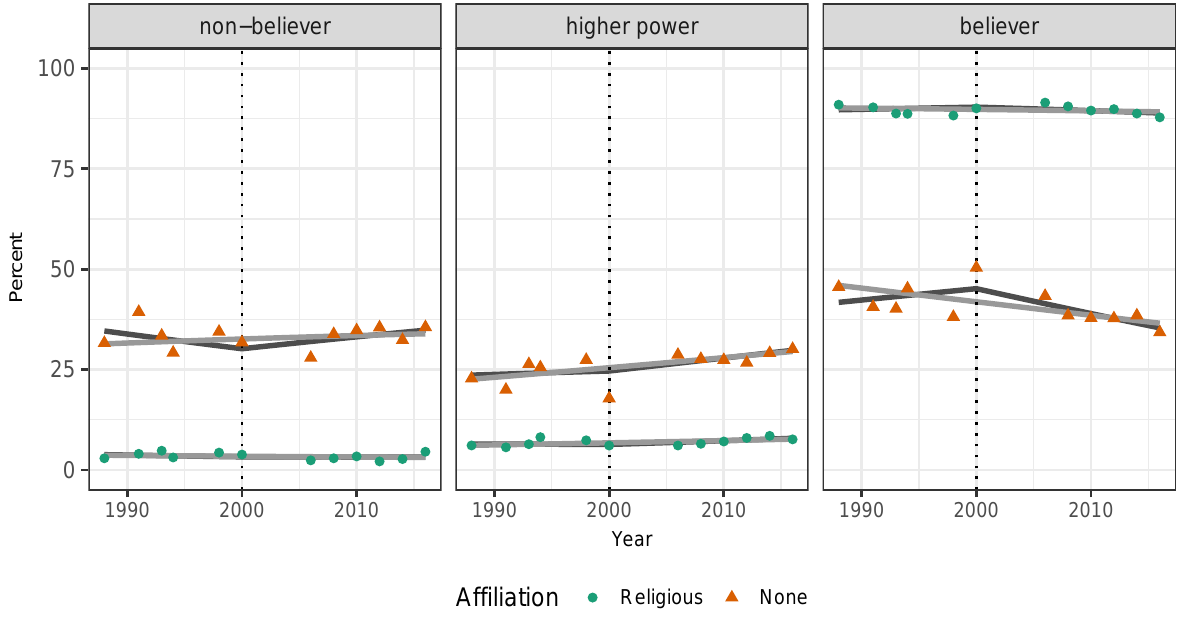
Figure 3: Percentage of General Social Survey respondents in each year who held given beliefs about God by affiliation status. All percentages are sample weighted. The fit of multinomial logit models assuming a linear trend and with a hinge at 2000 are shown in light and dark grey,